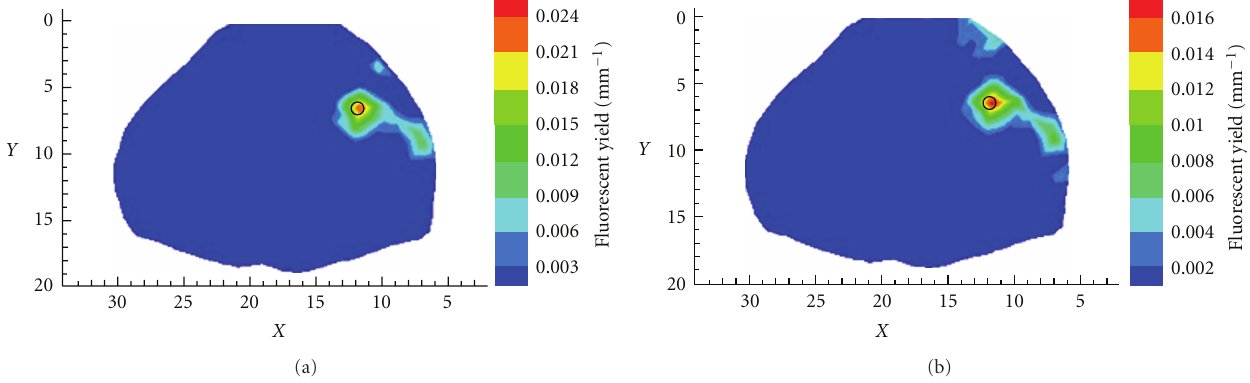
Figure 4: Reconstructed results at the coronal view by algebraic reconstruction technique (a) and l 2 -norm regularization method (b).